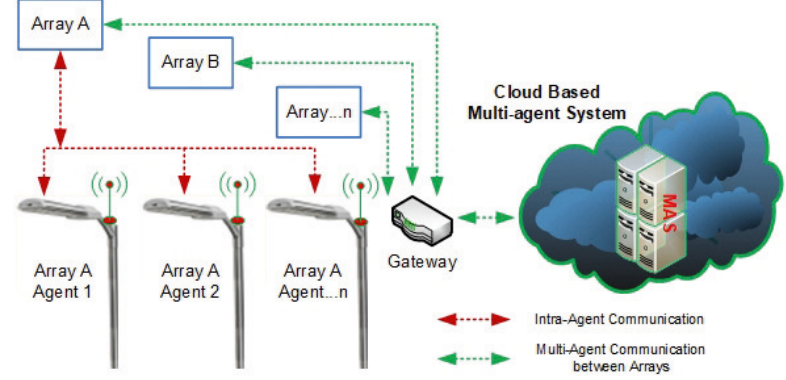
Figure 2. Remedial model indicating micro-arrays and